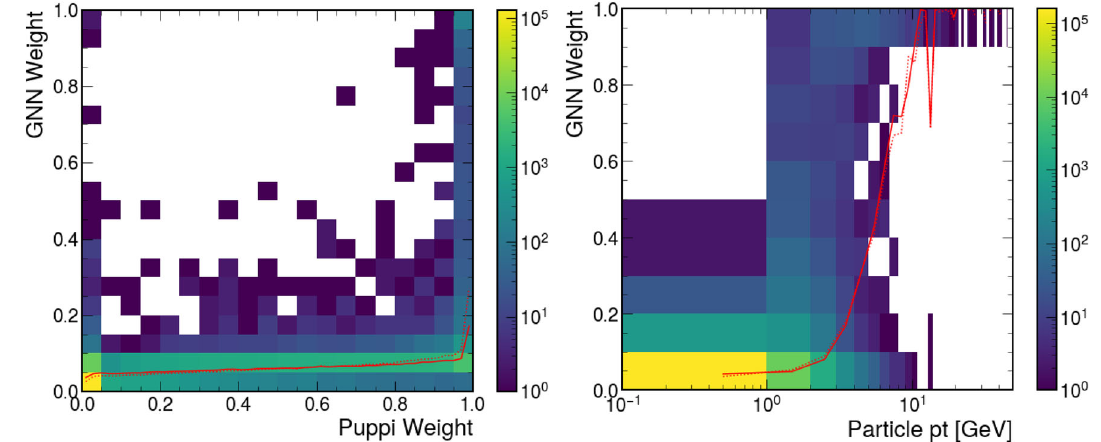
Fig. 10 GNN output with respect to the PUPPI weights (left) and the p T of neutral particles (right)